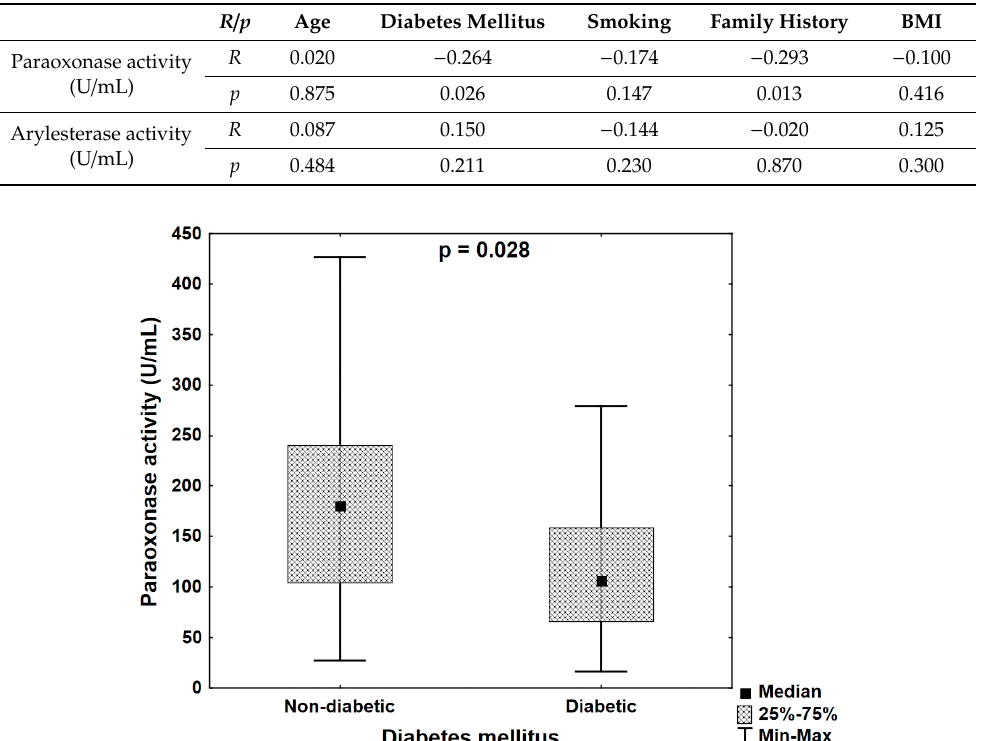
Figure 1. Paraoxonase activity in the groups of non-diabetic and diabetic patients (Mann–Whitney U test). The correlation analysis revealed the significant correlation between the premature CHD in family history and PON1 paraoxonase activity ( R = − 0.293, p = 0.013). PON1 paraoxonase activity in the group of patients with CHD in family history ranged from 27.34 to 256.97 (median 92.95) U/mL and was significantly lower ( p = 0.014) than in patients without positive family history (range